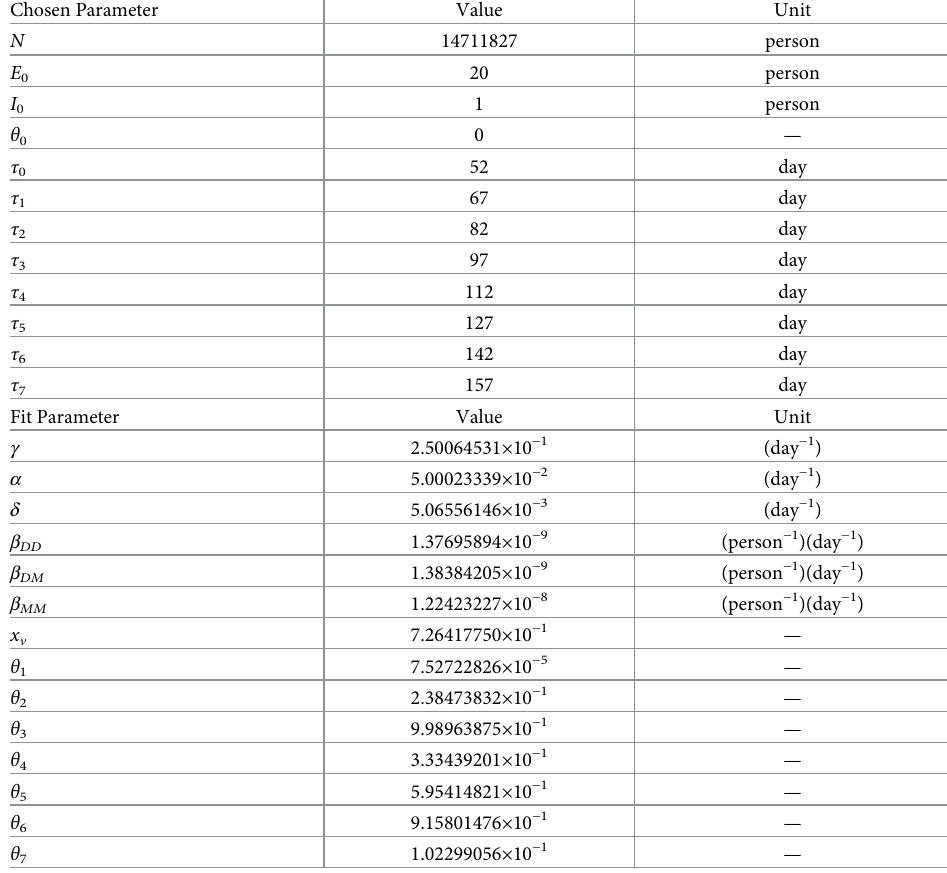
Table 1. Parameter values for the Distancing-SEIRD model. Parameter values for Eqs (3) and (4), and the public- response function, Eq (5), obtained by fitting to COVID-19 epidemiological data from Ontario between January